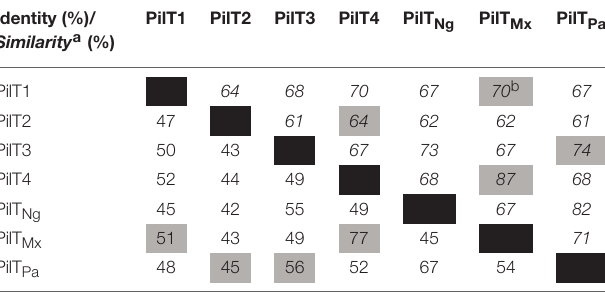
a Similarity values (above black boxes) are italicized. b Highest identities or similarities for each of the G. sulfurreducens PilT